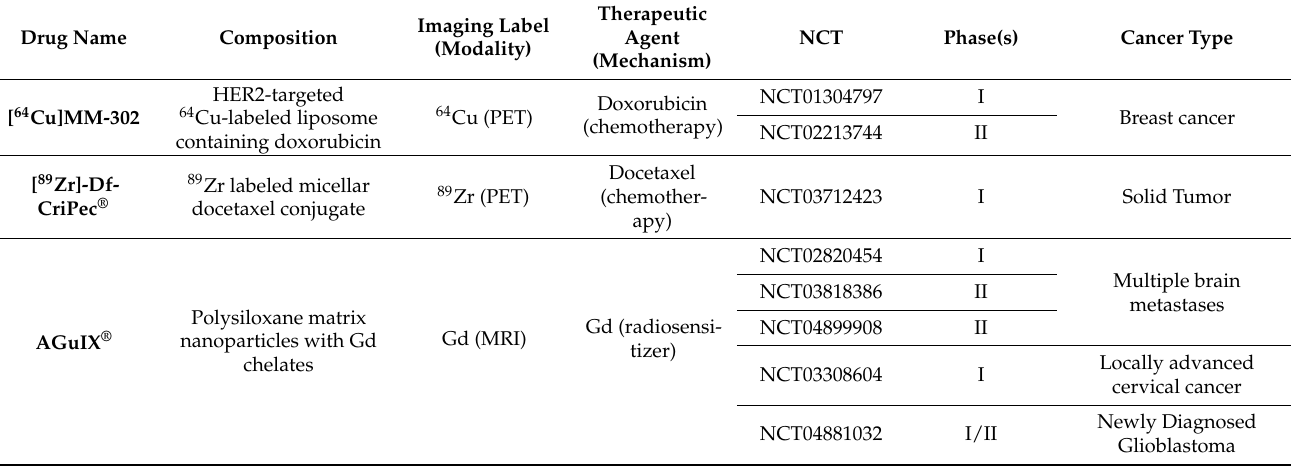
Table 3. Cancer nanotheranostics in clinical